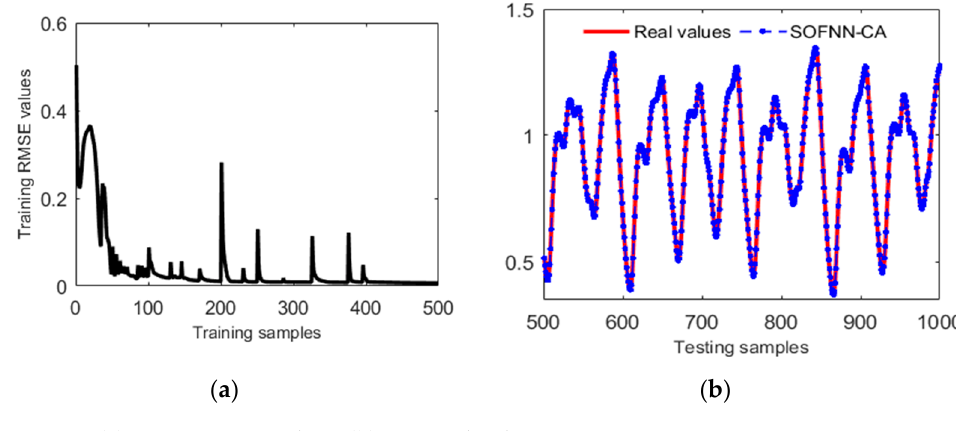
Figure 8. ( a ) Training RMSE chart; ( b ) test results chart. Table 1. Comparison results of different methods for predicting Mackey–Glass Time-Series.